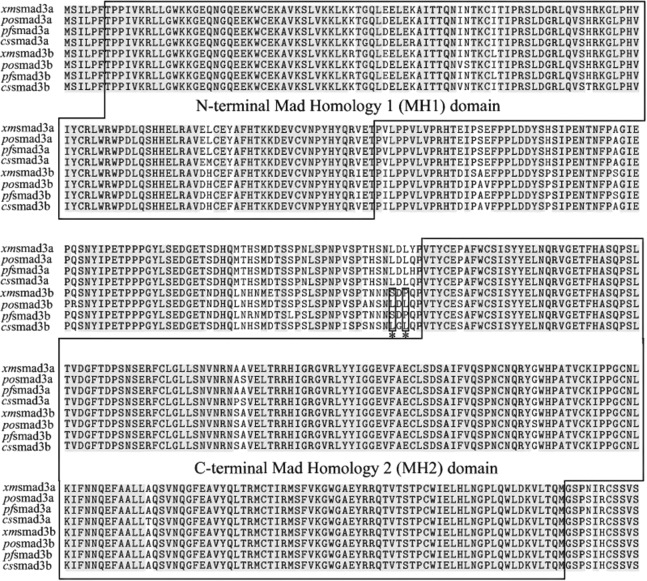
Sequence alignment of the deduced SMAD3a and SMAD3b protein sequences.Identical amino acids are in gray background. Two conserved domains, namely, MH1 and MH2 domains are marked in the figure. Two significantly positively selected sites are indicated by asterisk.